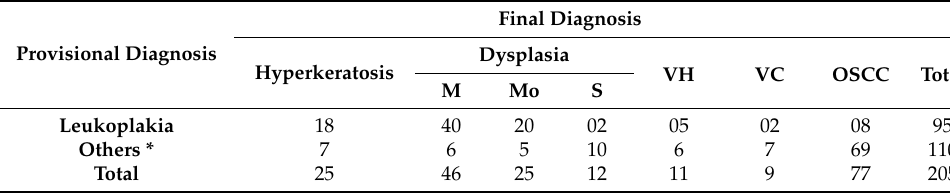
Table 2. Total number of cases